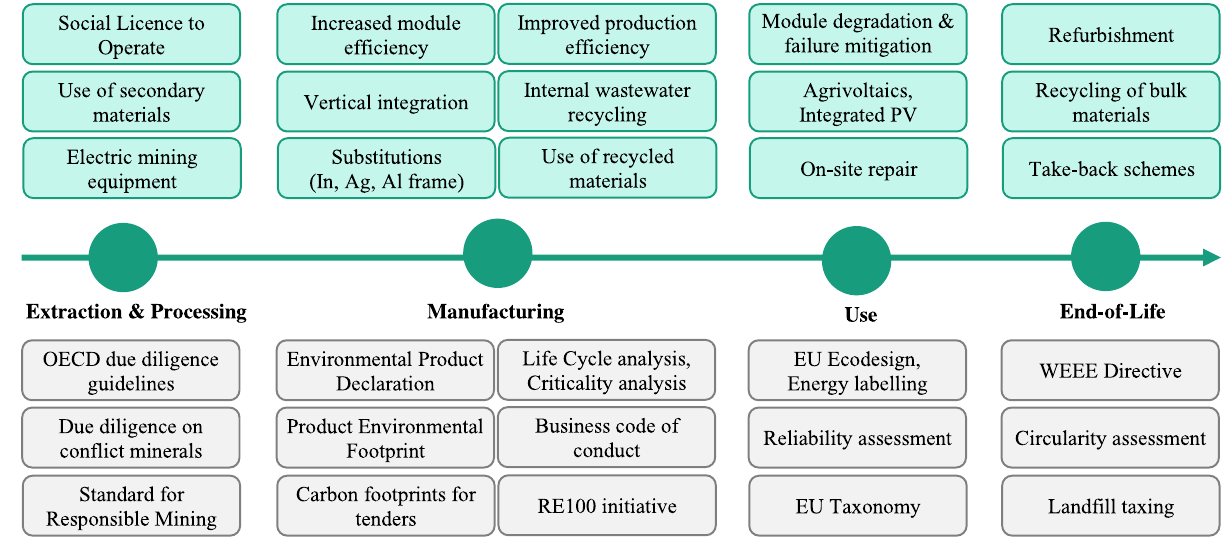
Fig. 1. Excerpt of the sustainability landscape over the PV value chain. Practices implemented or in development for industrial applications are in green; policies, research instruments and standards are in